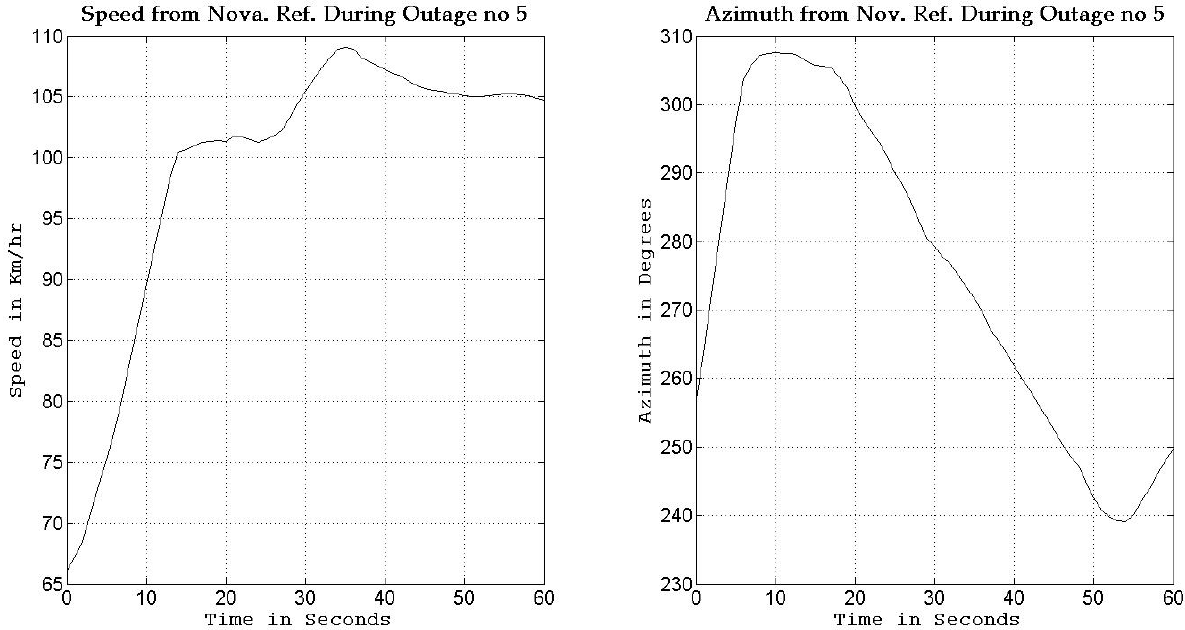
Figure 7. Forward speed and azimuth from Novatel reference during GPS outage #5 of the first trajectory.